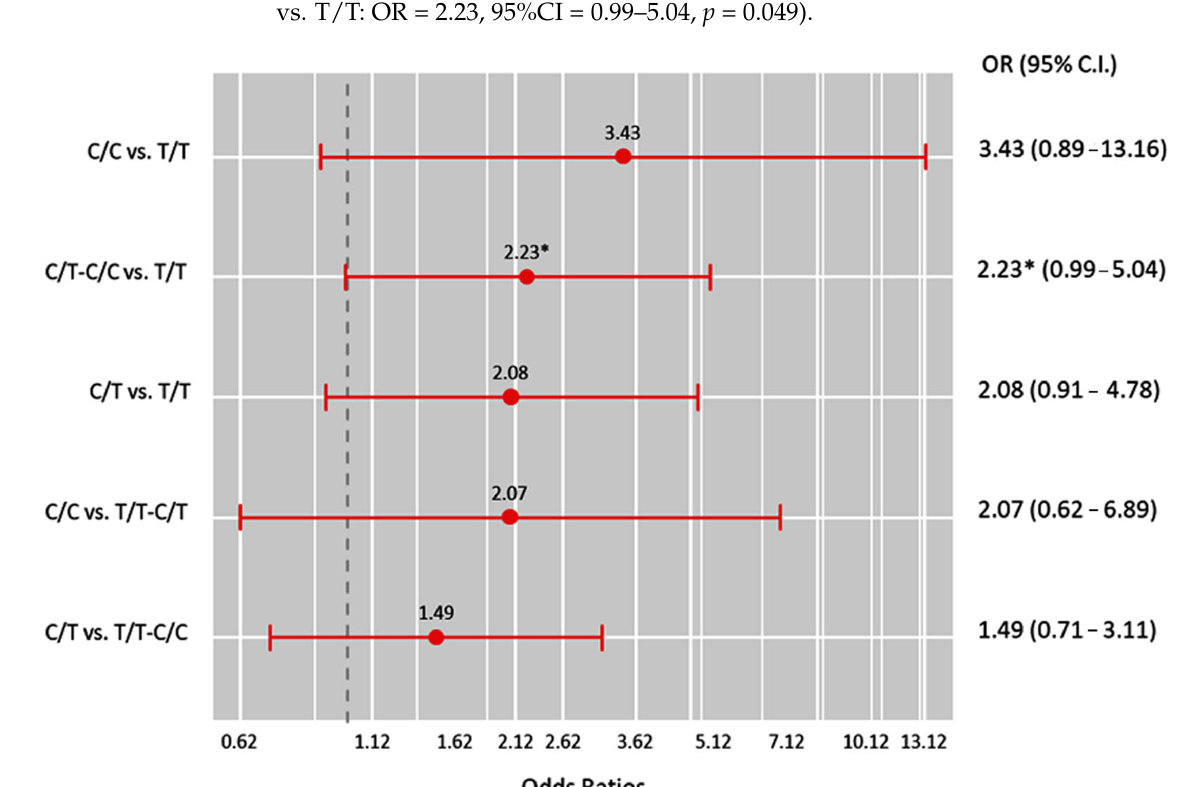
Figure 2. Genetic association models for propensity-matched cohorts (each = 71). OR (95% C.I.): odds ratio (95% confidence interval). * p -value < 0.05.